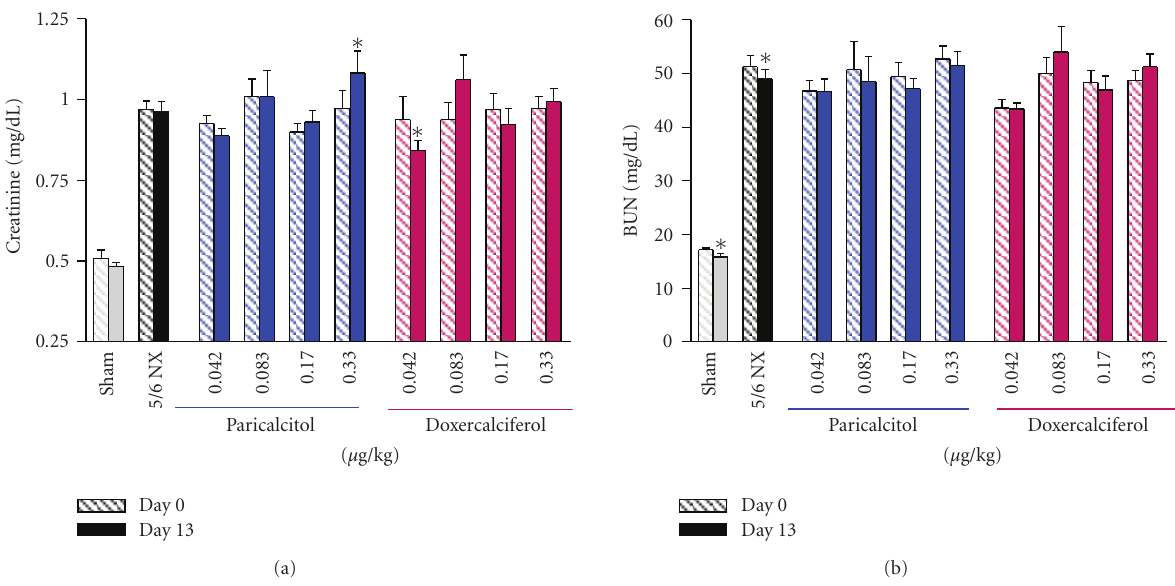
Figure 2: The serum creatinine and BUN levels in 5/6 nephrectomized (NX) uremic rats. 5/6 NX rats on normal diet were treated with vehicle, paricalcitol, or doxercalciferol at indicated doses, i.p., 3 times/week, for two weeks ( n = 8–12 per group). Sham-vehicle rats were dosed with vehicle. Handling of animals was as described in Materials and Methods. Blood samples were collected for the measurement of serum creatinine and BUN. Mean ± standard error was calculated for each group. Unpaired t-test with 95% confidence intervals of di ff erence was performed for statistical comparisons. ∗ P < . 05 versus Day 0 (before dosing at six weeks after the surgery). Day 13: after dosing with vehicle or